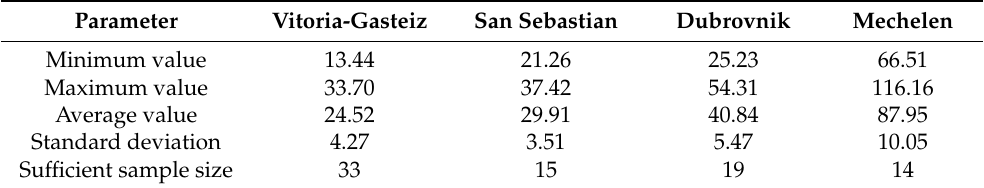
Table 3. Parameters of the total distance covered by traditional vehicles for the scenario where cargo bikes are used for deliveries of small-size packages